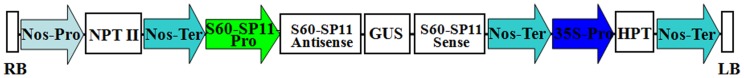
Schematic representations of the S60-SP11RNAi vector construct.A 285 bp cDNA fragment of S60-SP11 was put into the upstream and downstream of the 1023 bp Gus linker of binary vector pBI101 in opposite orientations under control of the S60-SP11 promoter. LB, left border of T-DNA; NPTII, gene for neomycin phosphotransferase for kanamycin resistance; 35S-Pro, 35S promoter of cauliflower mosaic virus; Nos-Pro, promoter of nos (nopaline synthase) gene; Nos-Ter, terminator of nos (nopaline synthase) gene; S60-SP11 pro, S60-SP11 promoter; HPT, the Hygromycin-resistance gene; RB, right border of T-DNA.